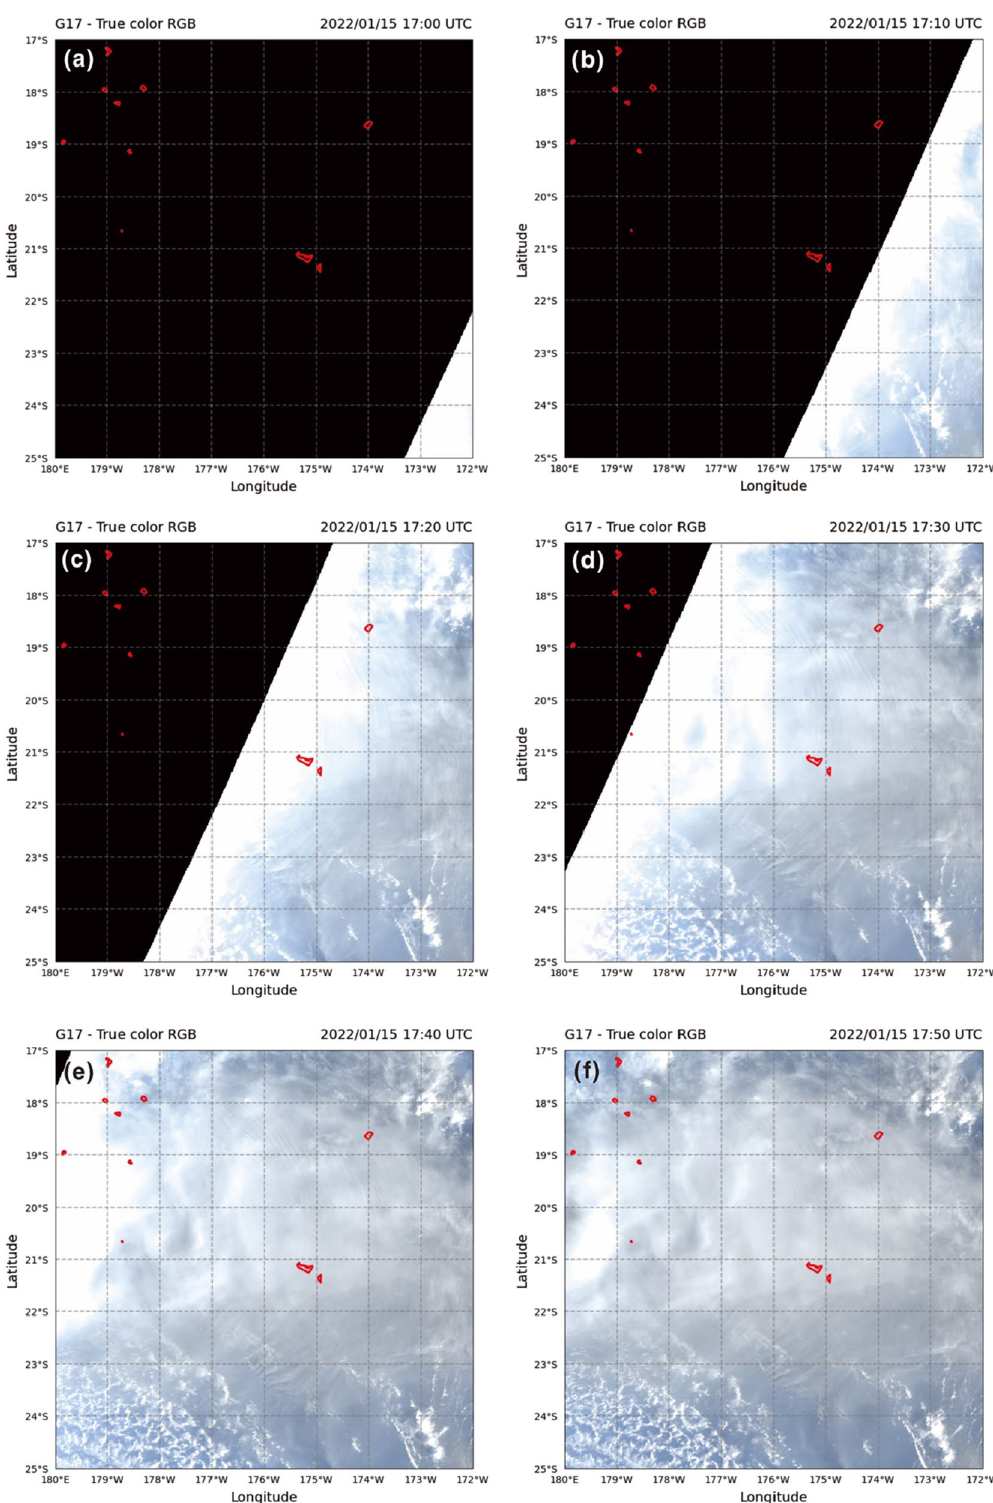
Fig. 12 True color RGB using GOES-17 from 17:00 to 17:50 on 15 January 2022. ( a ) 2020/01/15 17:00 UTC, ( b ) 2020/01/15 17:10 UTC, ( c ) 2020/01/15 17:20 UTC, ( d ) 2020/01/15 17:30 UTC, ( e ) 2020/01/15 17:40 UTC, ( f ) 2020/01/15 17:50